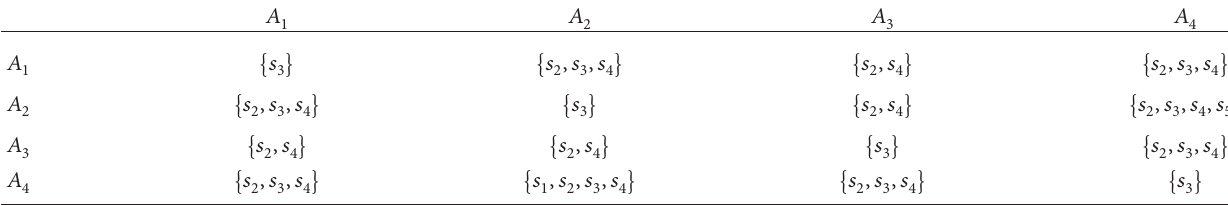
Table 4: The hesitant fuzzy preference